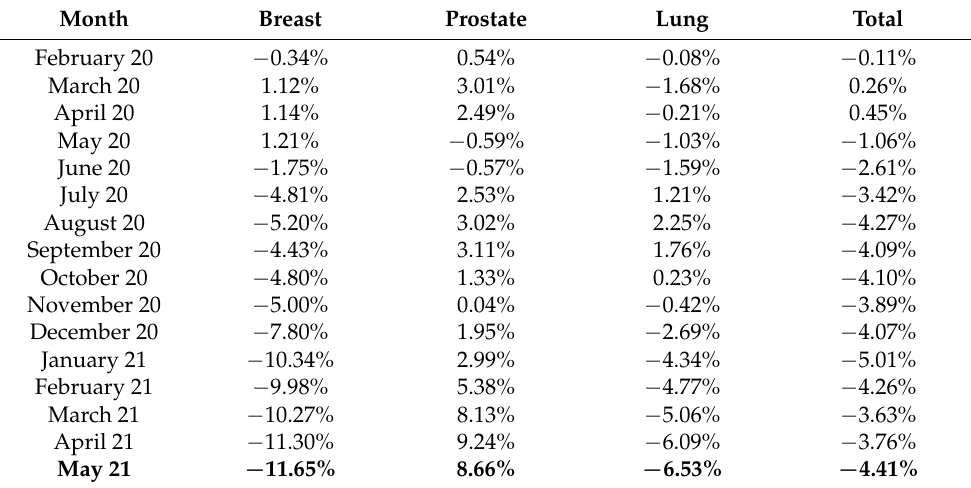
The bold emphasizes that this row represents the cumulative numbers after 16 months, which are referenced in the